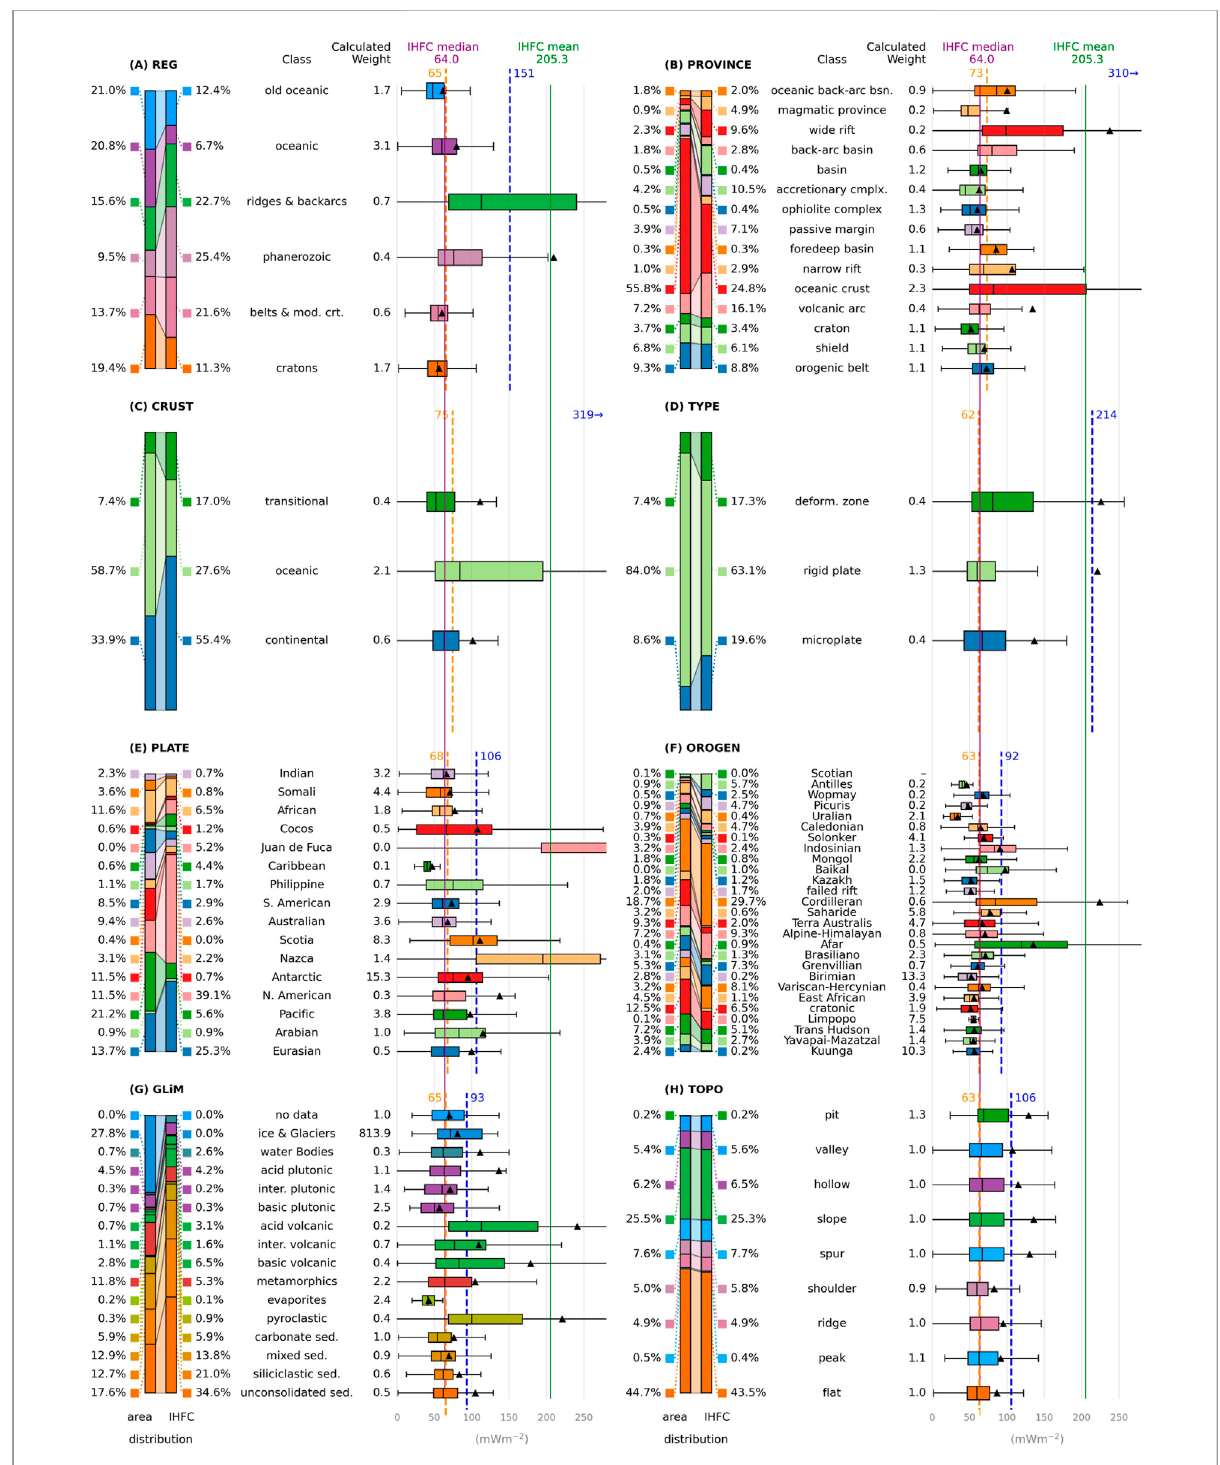
FIGURE 2 (Previous page.) Categorical classes in auxiliary variables, as sampled and heat distribution for each class. (A) Regionalisation from seismic surfacewave tomography (Schaeffer andLebedev, 2015) (B) Province type(Hasterok etal.,2022) (C) Crustal type(Hasteroket al.,2022) (D) Tectonic plate type (Hasterok et al., 2022) (E) Tectonic plate name (Hasterok et al., 2022) (F) Last orogeny (Hasterok et al., 2022) (G) Lithological class (Hartmann and Moosdorf, 2012) (H) Geomorphometric shape (Amatulli et al., 2020) From left to right within each subplot: Percentage of